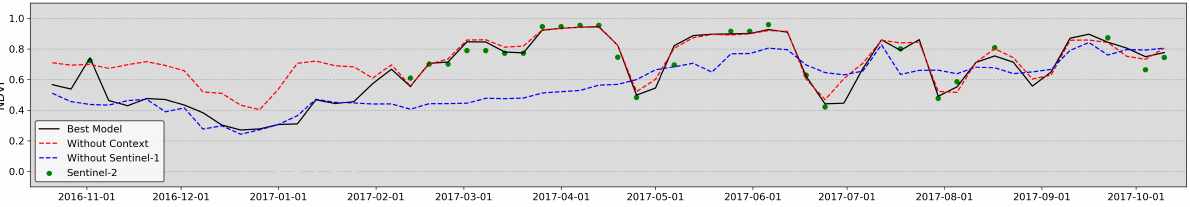
Figure 4. Results of different reconstructions of NDVI time series with various feature sets for one grassland parcel. Only non-cloudy S2 values are shown. It shows that SenDVI can restore the signal despite clouds (S1 features) while keeping only significant high frequencies (context features).